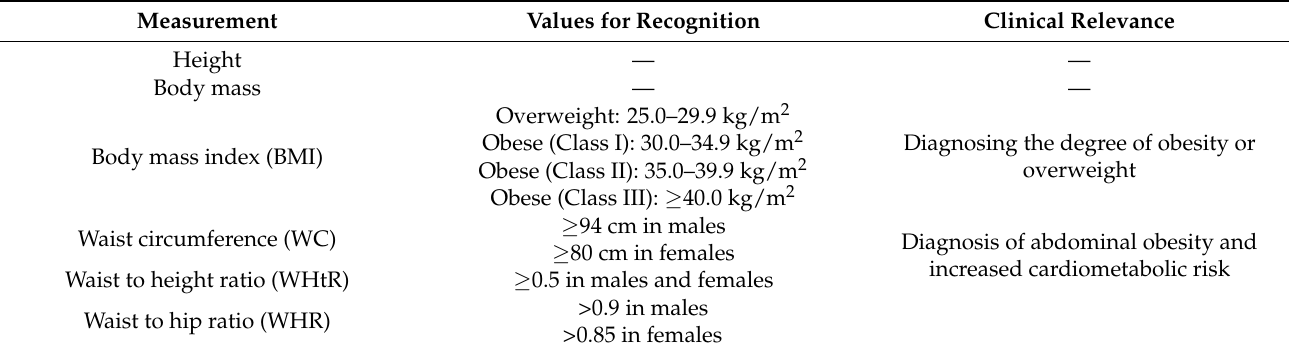
Table 2. Anthropometric measurements for obesity assessment.